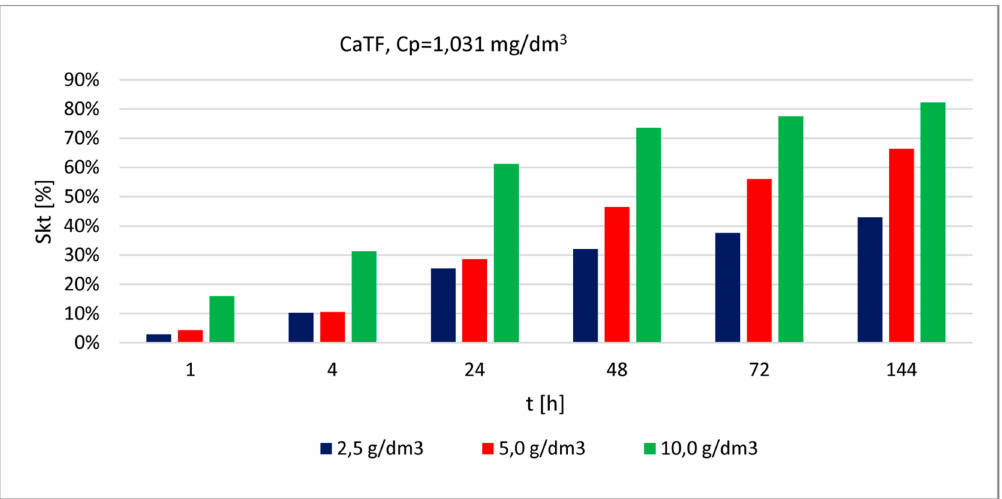
Figure 4. Phosphate removal e ffi cacy (1.031 [mg / dm 3 ]) by CaTF (dose: 2.5; 5.0; 10.0 [g / dm 3 ]) at di ff erent contact time